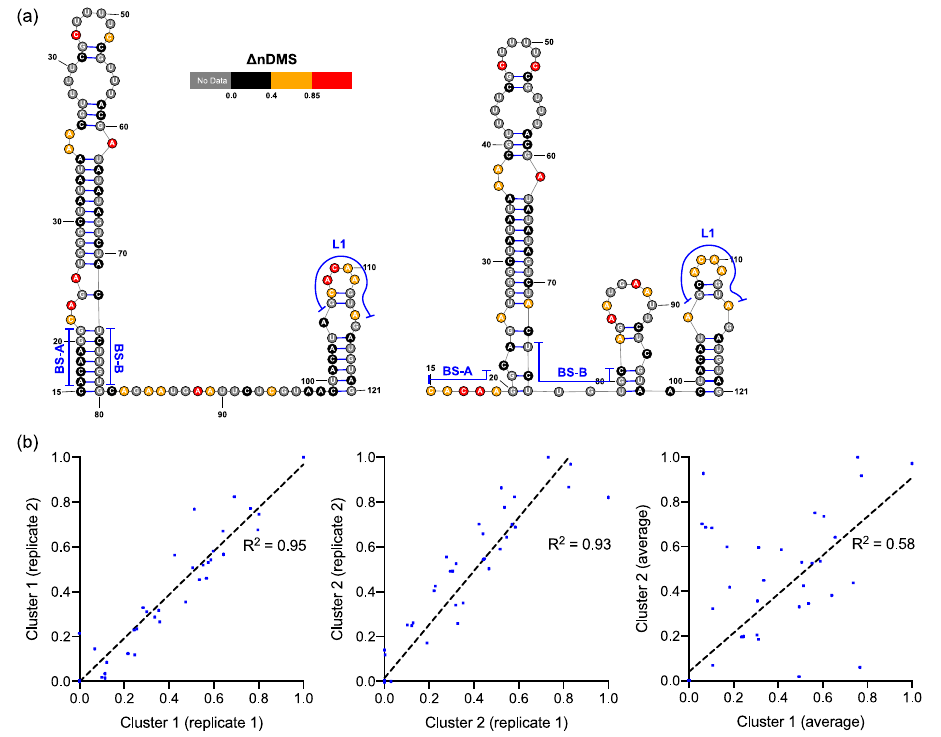
Figure 5. ( a ) Two predominant conformations of bulged stem-loop (BSL) and stem-loop 1 (SL1) uncovered by the DREEM analysis on the DMS-MaPseq reads that cover > 95% of the region. The illustrated structures were derived from replicate 2 data set. ( b ) Correlation in Δ nDMS activity profiles for the same structural cluster between the replicates and between two clusters.